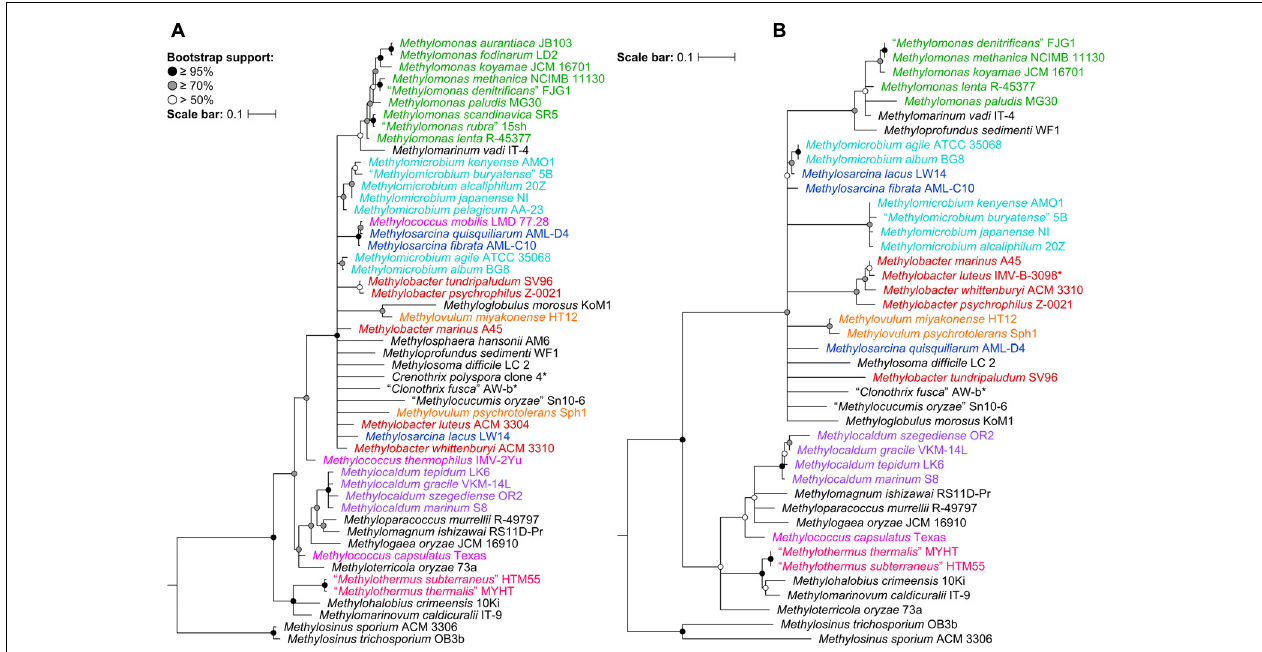
FIGURE 1 | The phylogenetic relationship of Methylococcales type and representative strains based on (A) 16S rRNA and (B) PmoA sequences. The maximum-likelihood trees were constructed from the alignments of (A) 16S rRNA (1,469 nucleotide positions) and (B) PmoA (243 amino acid positions) sequences. Methylosinus was chosen as outgroup. Nodes with 50% or less bootstrap support are collapsed. Bootstrap support is indicated on the nodes as black ( ≥ 95%), gray ( ≥ 70%), or white ( > 50%) circles. The scale bars represent (A) nucleotide or (B) amino acid substitutions per site. Genera with at least two members are colored; genera with single members (and outgroup) are black. Asterisks indicate non-type strains.